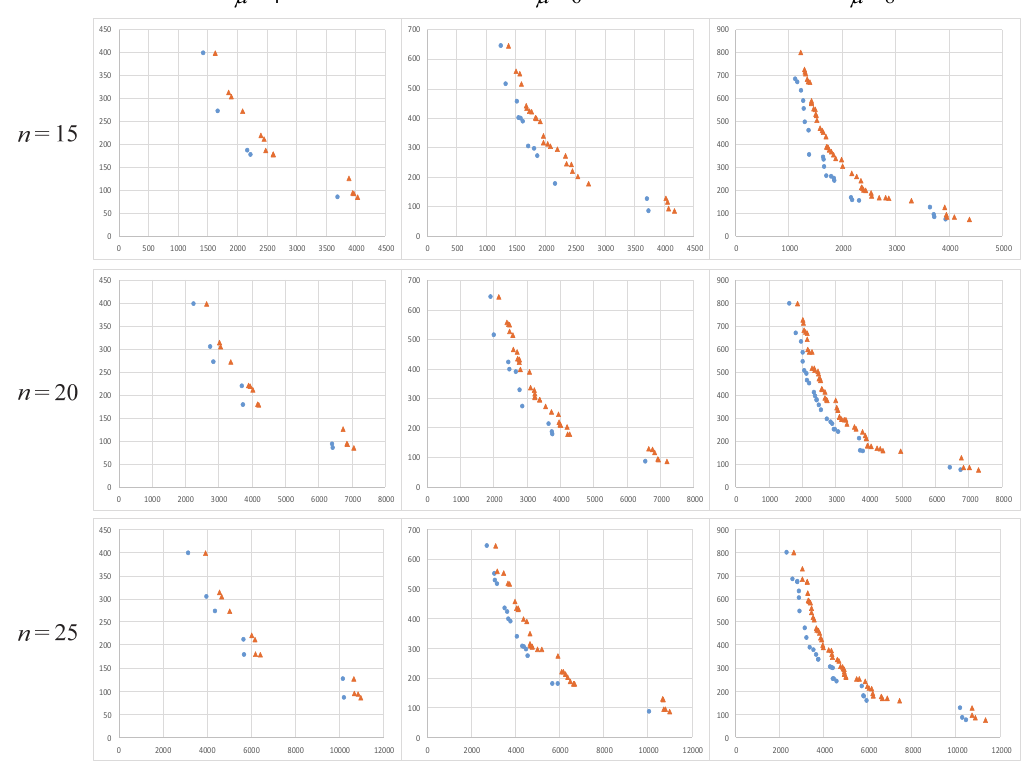
PF (dots) and anti fronts T